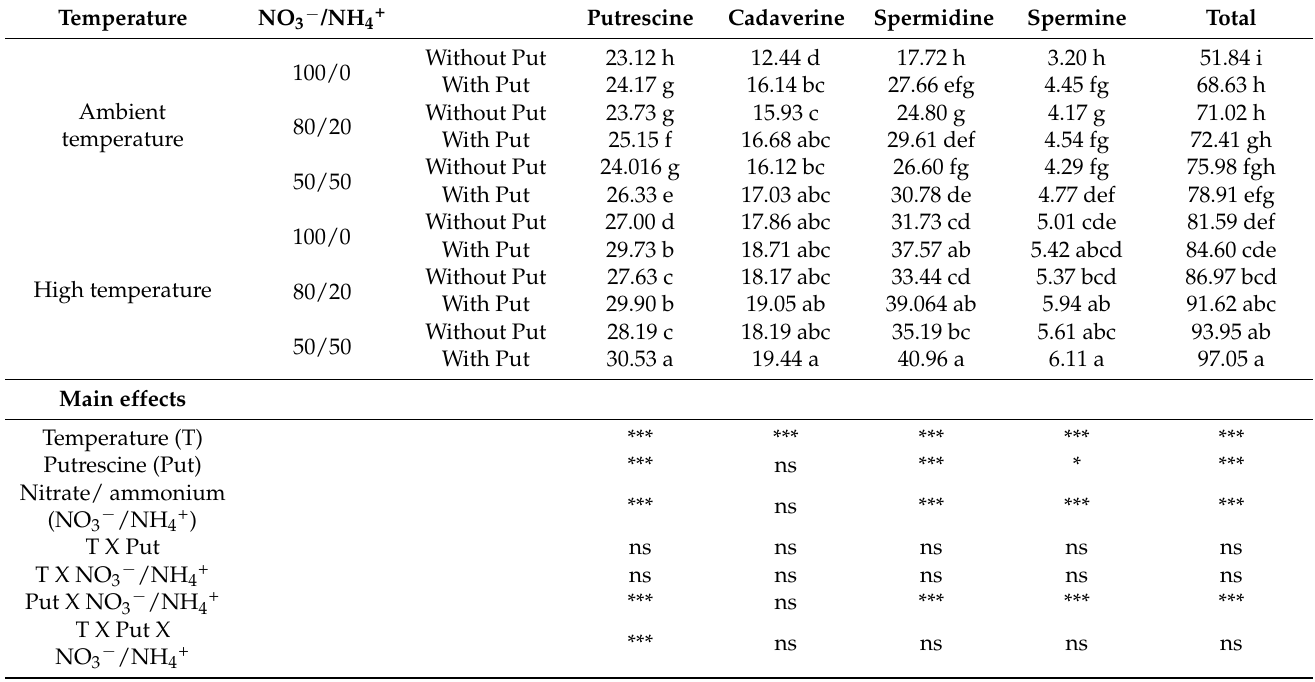
Table 5. Effect of the foliar application of putrescine on the concentrations of polyamines (nmoles g − 1 ) in younger leaves of the cauliflower cv. Moonshine at different NO 3 − /NH 4+ ratios and